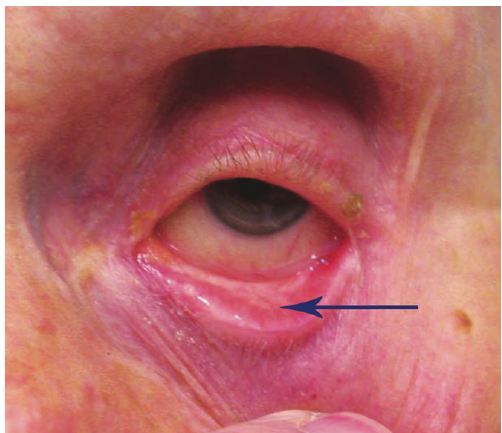
Figure 2: Age-matched control lower eyelid. Blue arrow points to the inferior border of the tarsus where there is not a “V” shaped junction between the retractors and inferior border of the tarsus. There is no orbital fat prolapse and no “white